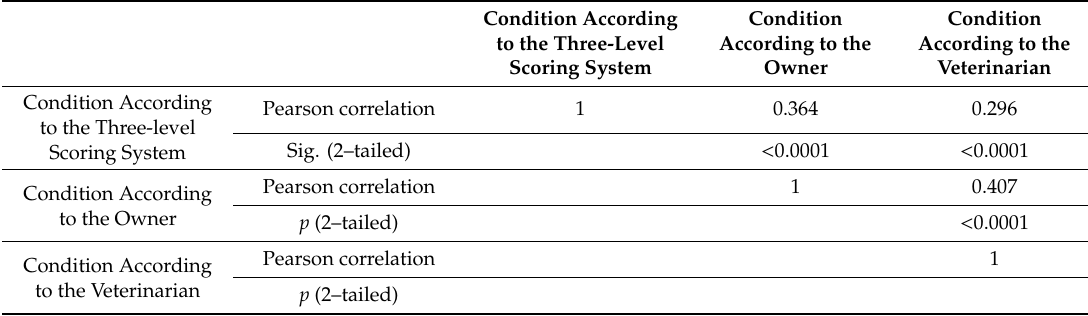
Table 3. Pair-wise correlations between the three methods of assessing a dog’s body condition.